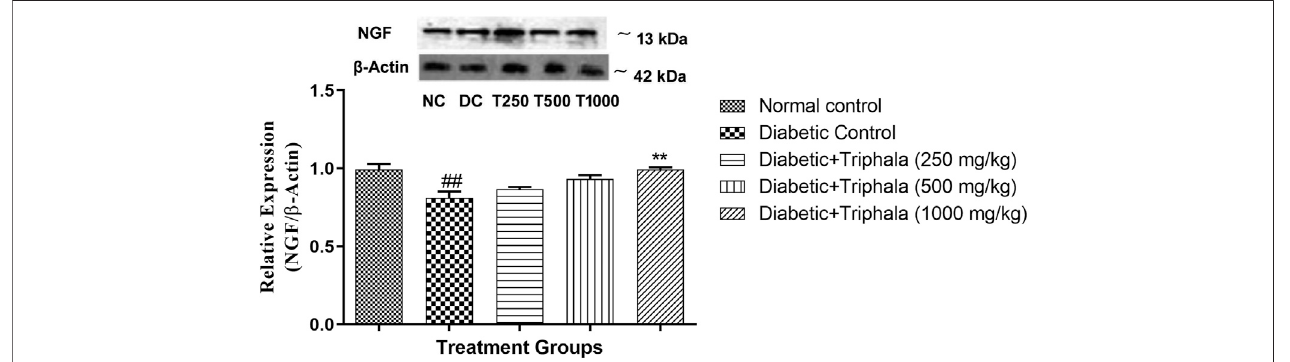
FIGURE 4 | Effect of Triphala churna on NGF expression. All data is expressed as Mean ± SEM ( n (cid:2) 3). ### p < 0.001 when compared with normal control, ** p < 0.01 when compared with diabetic control.